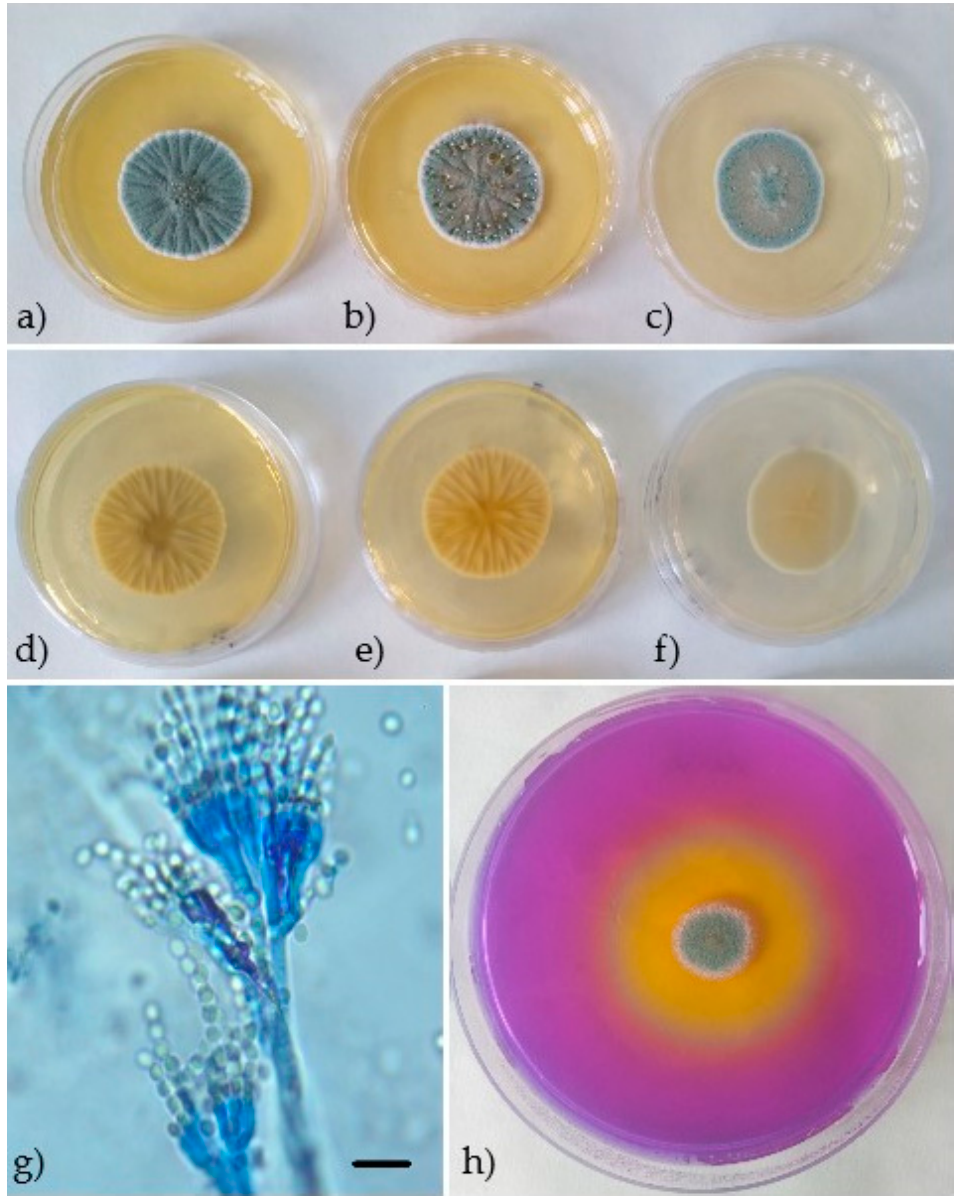
Figure 3. Penicillium crustosum . Seven-day-old colonies on Malt Extract Agar (MEA) ( a ) obverse, ( d ) reverse, Czapek Yeast Autolysate agar (CYA) ( b ) obverse, ( e ) reverse, Yeast Extract Sucrose agar (YES) ( c ) obverse, ( f ) reverse, ( h ) Creatine Sucrose Agar (CREA)—good acid production, ( g ) conidiophores and conidia. Scale: black bar = 10 μ m.